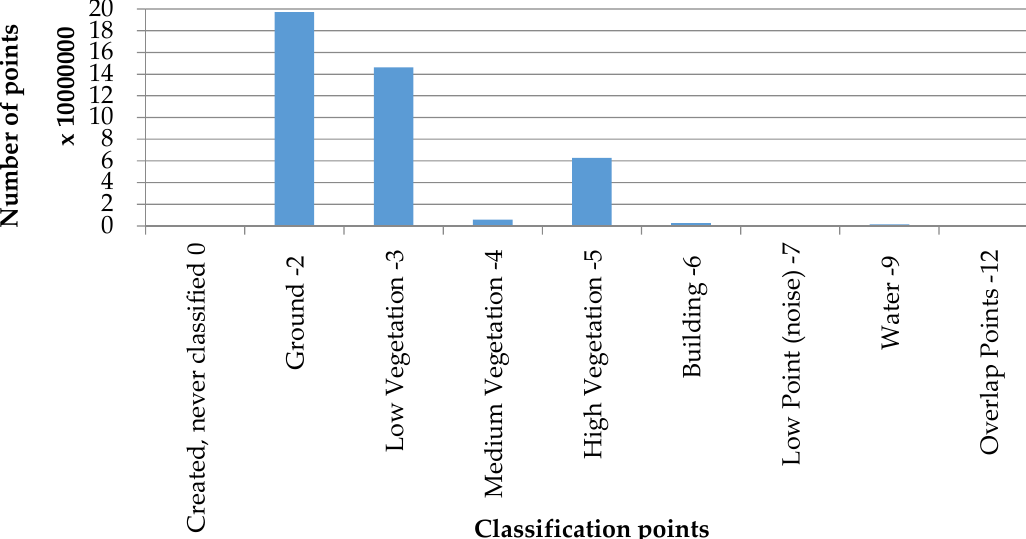
Figure 2. LIDAR point cloud ( a ) before and ( b ) after filtration. Points with errors and small and medium flora and trees were filtered out (Figure 3).